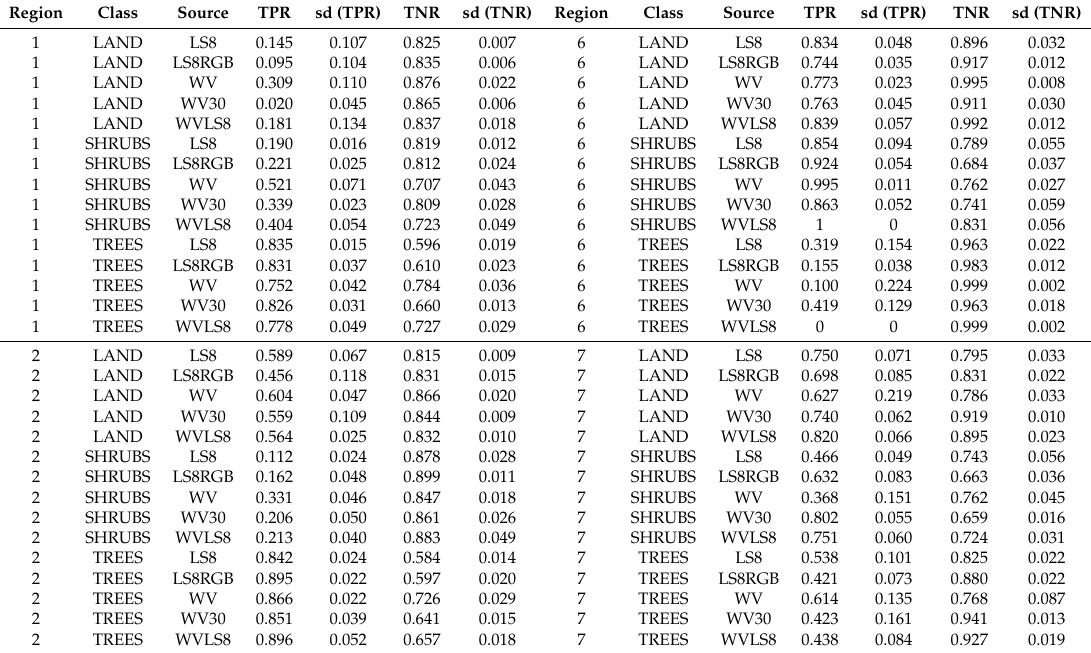
Table A7. Main classifier performance results (data from Figure